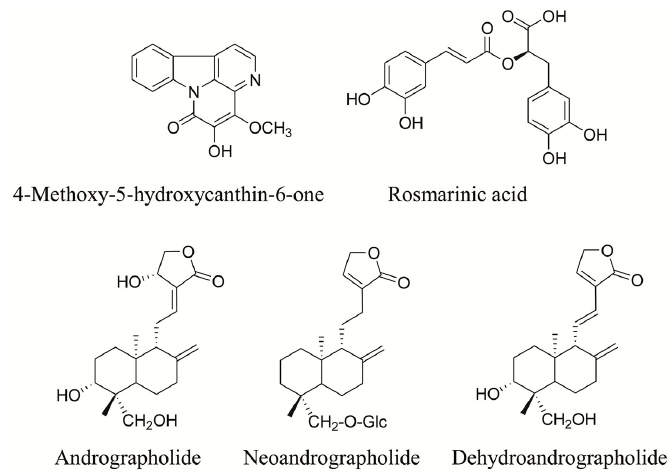
Figure 1. Chemical structures of the five bioactive components of XYLDTs.